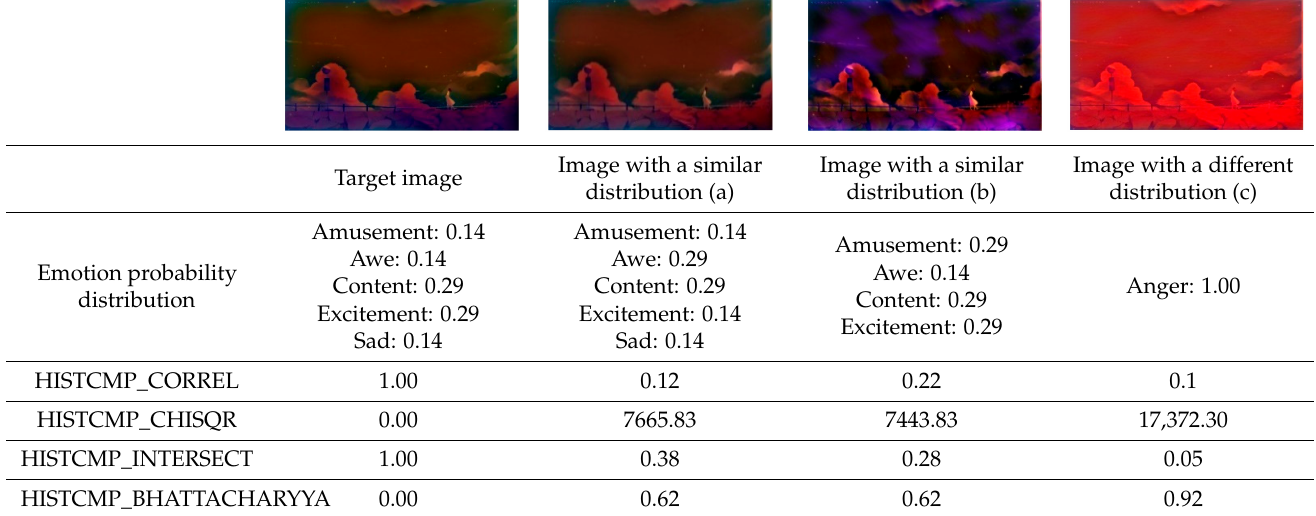
Table 5. Result of histogram comparison using compareHist